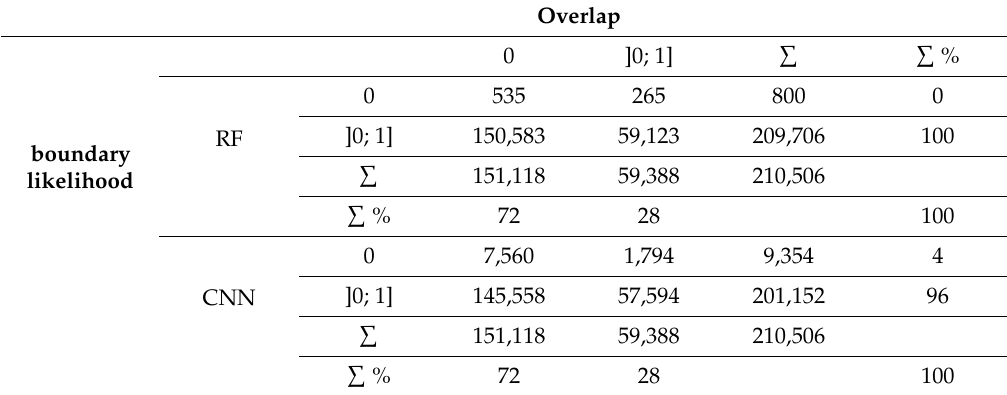
Table 4. Is the boundary likelihood predicted for the correct